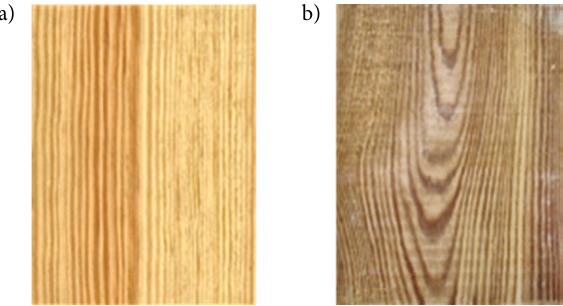
Fig. 16. A view of timber specimens: a – without preservative; b –